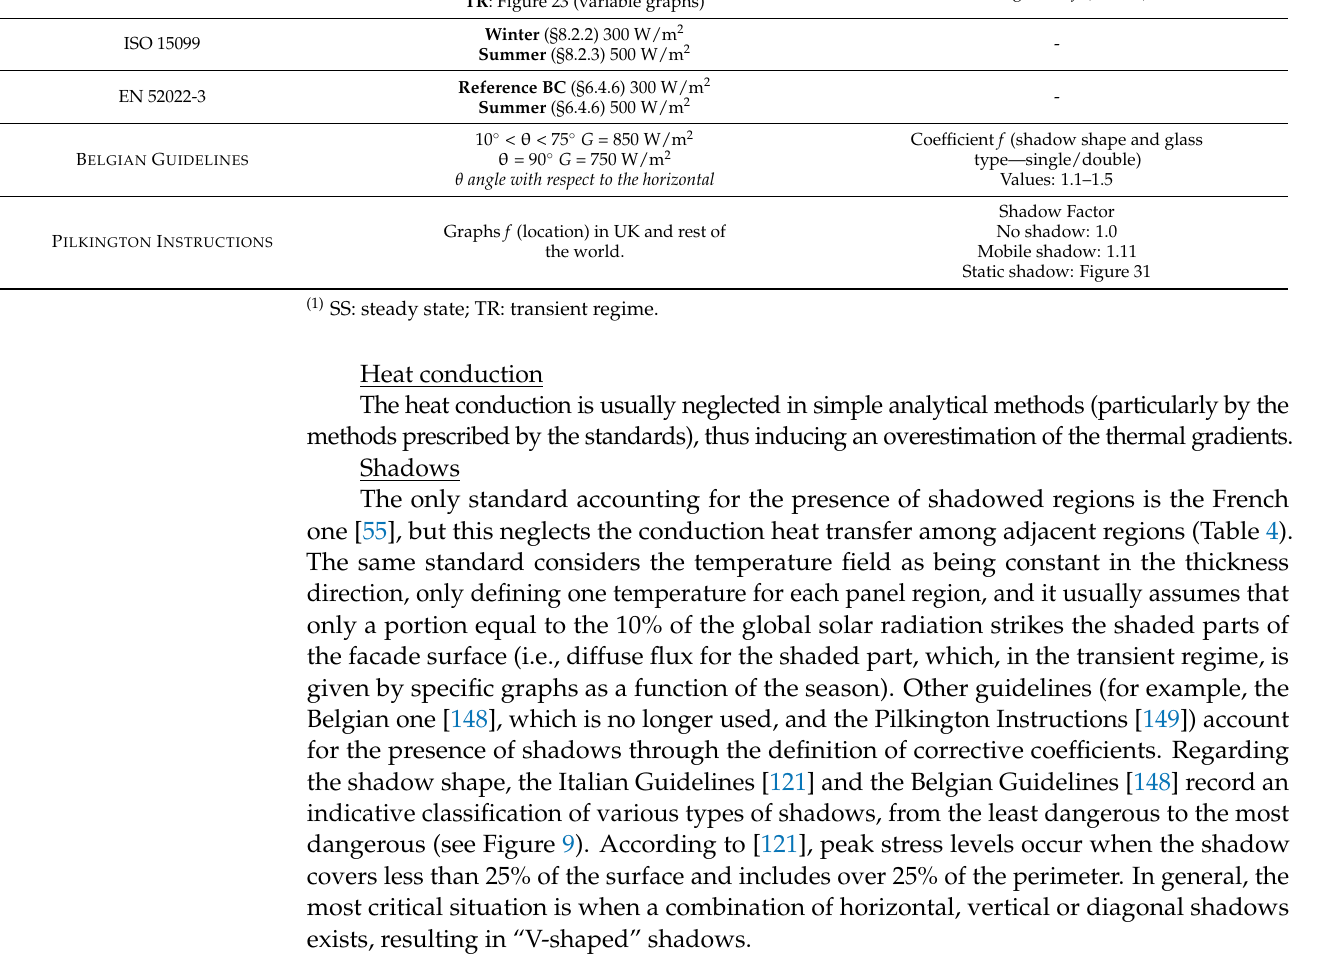
10% of the global solar radiationin the shaded parts SS : min 75 W/m 2 TR : Figure 24 f (season)